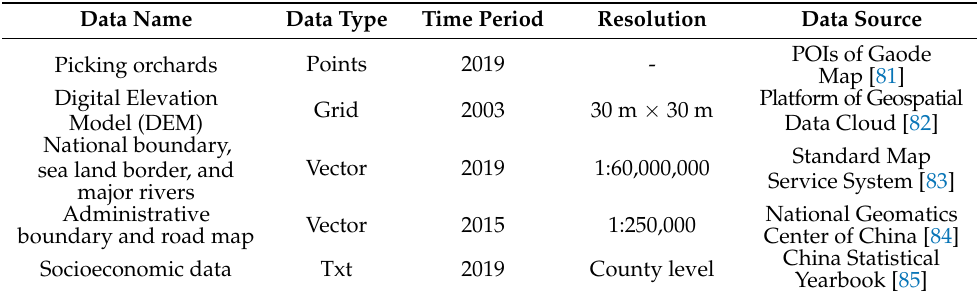
Table 1. Data sources and